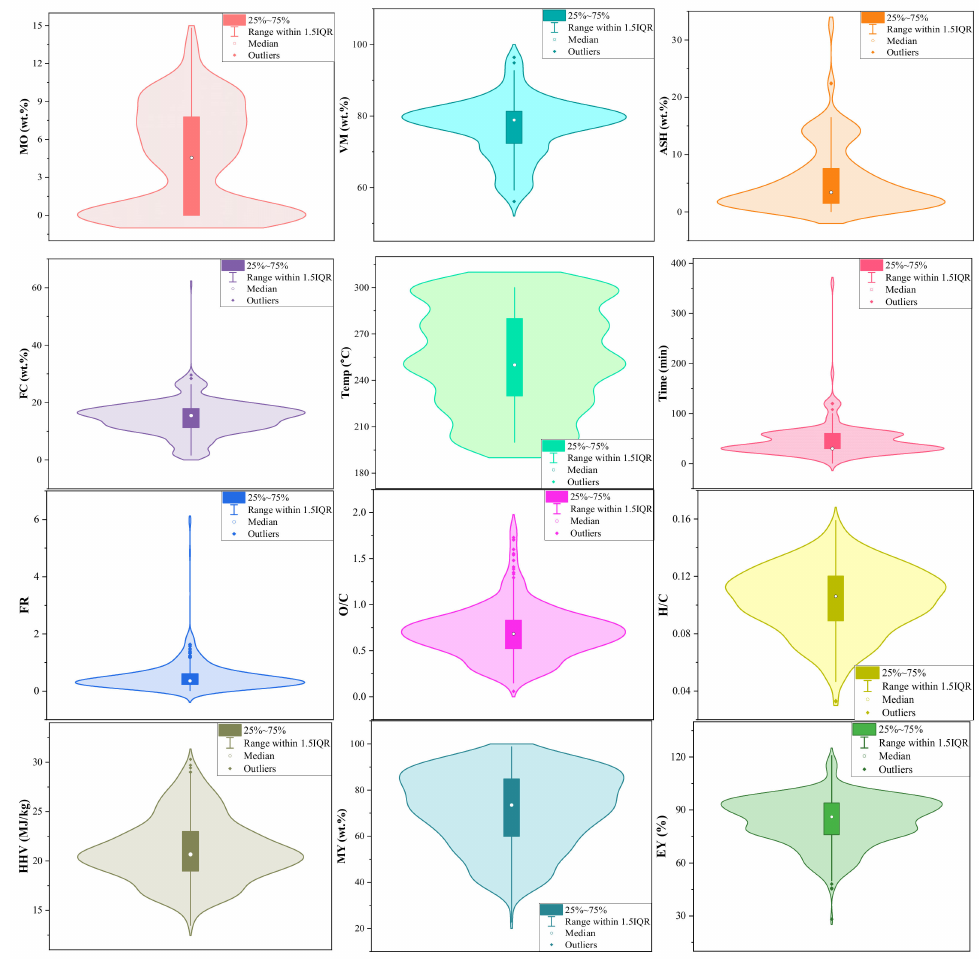
Figure 3. The statistical distribution of each variable in terms of the inherent properties of the raw biomass, the torrefaction conditions, and the fuel properties of torrefied biomass with violin plots.